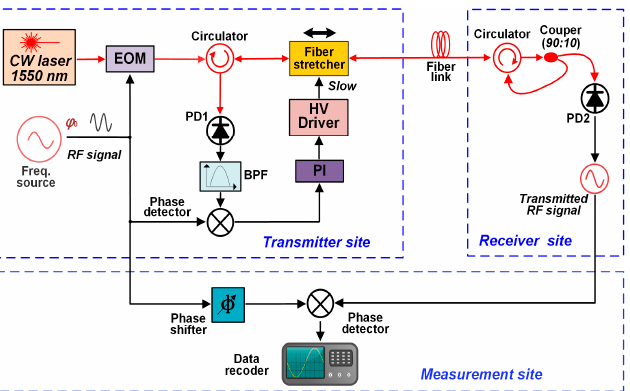
Figure 1. Schematic of typical fiber-based frequency transfer with optical compensation. CW: continuous wave, EOM: electro-optical modulator, BPF: band-pass filter, HV: high voltage, PD: photodiode, PI: proportional-integral controller, FFT: fast Fourier transform.